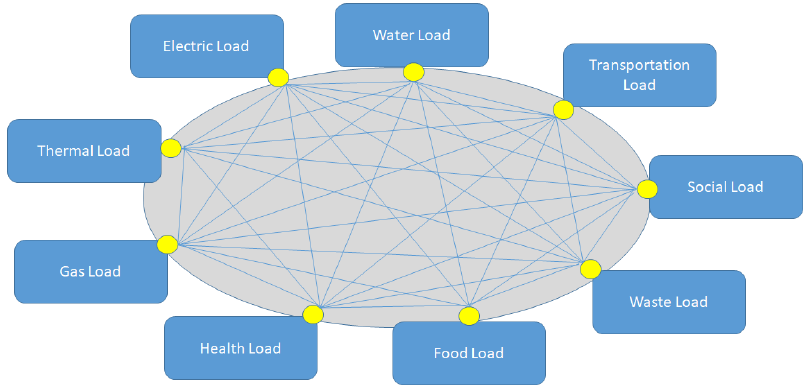
Figure 5. Possible interactions among different loads within interconnected infrastructures.